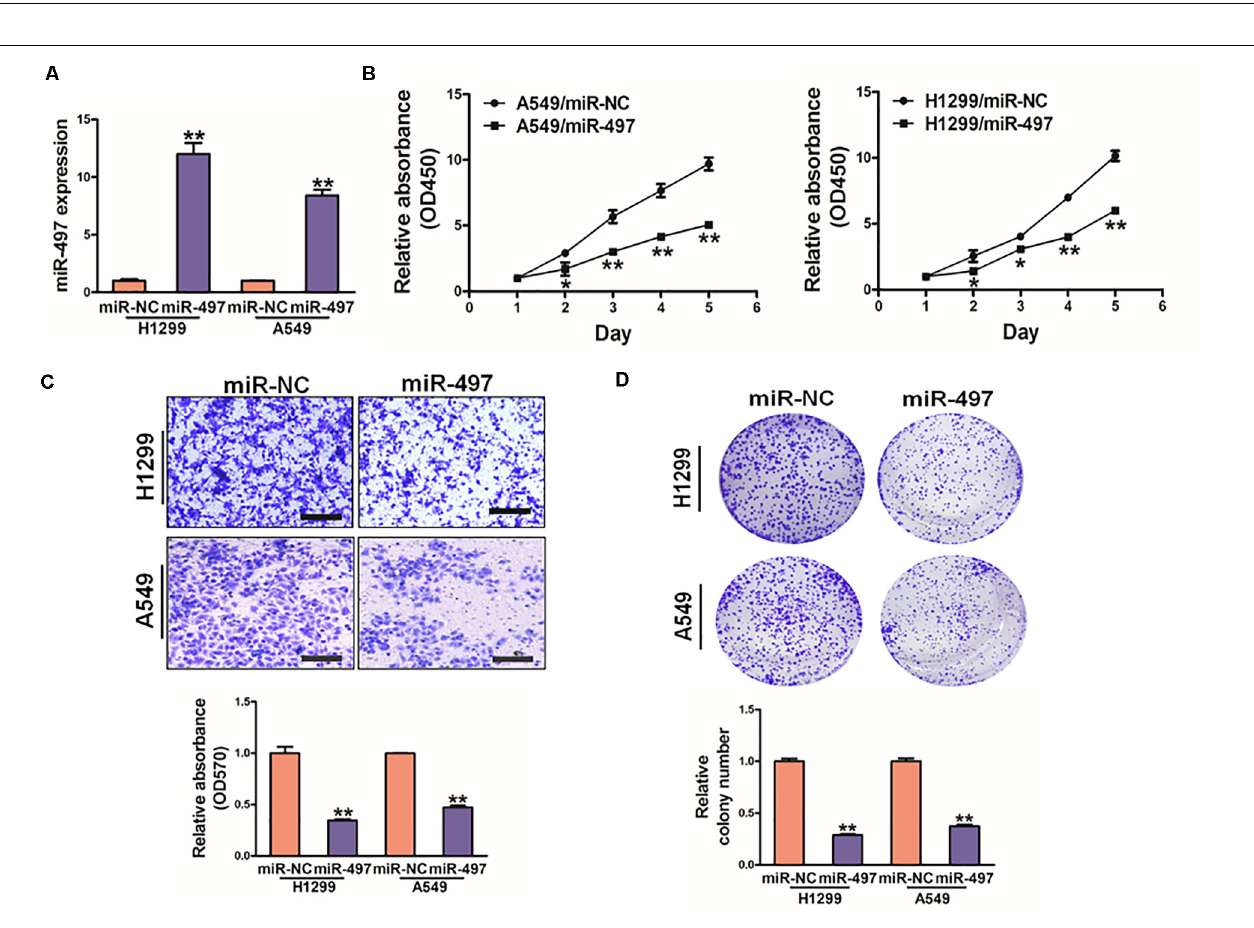
FIGURE 4 | MiR-497 overexpression suppresses cell proliferation, migration and colony formation of lung cancer cells. (A) Expression levels of miR-497 was conducted in A549 and H1299 cells. (B) Overexpression of miR-497 decreased cell growth activity. (C) Migration assay of A549 and H1299 cells. The results showed that overexpression of miR-497 inhibited cell migration. (D) Colony formation was conducted in indicated cells, while the activity of colony formation were reduced in miR-497 group compared with miR-NC. Data were presented by mean ± SD. of 3 replicates. *indicated P < 0.05, **indicated P < 0.01.